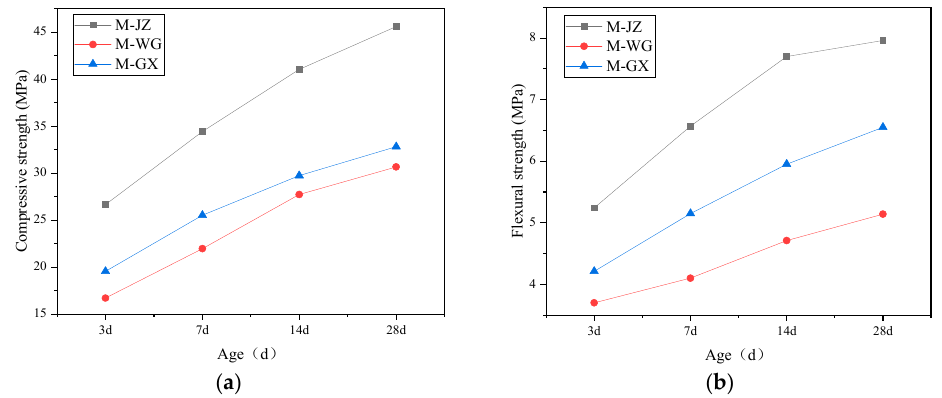
Figure 7. The flexural and compressive strength of ordinary mortar (M-JZ), recycled mortar (M- WG) and modified recycled mortar (M-GX). ( a ) Compressive strength, ( b ) Flexural